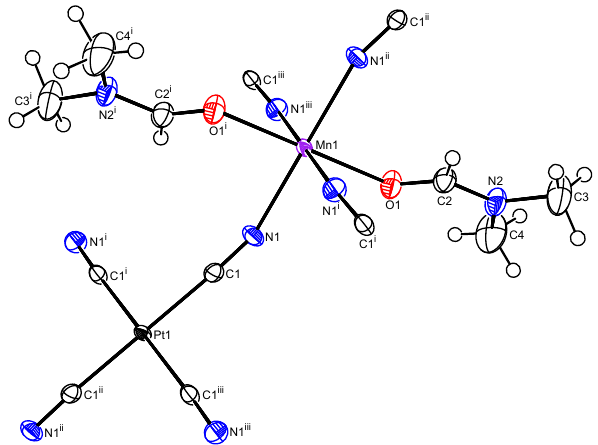
Table 1 contains crystallographic data and Table 2 contains the list of the atoms including atomic coordinates and displacement parameters.